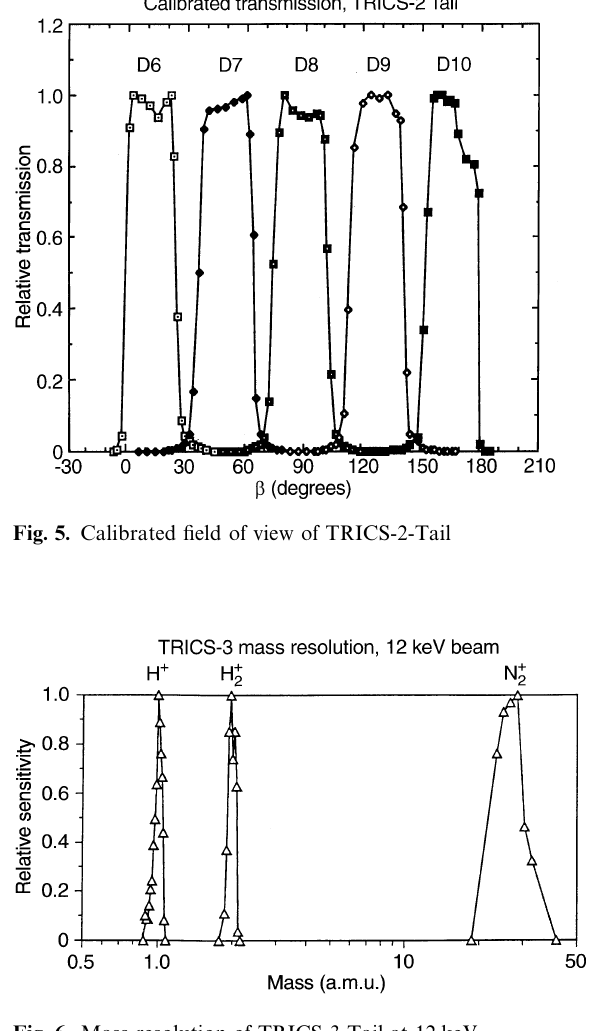
Fig. 6. Mass resolution of TRICS-3-Tail at 12 keV